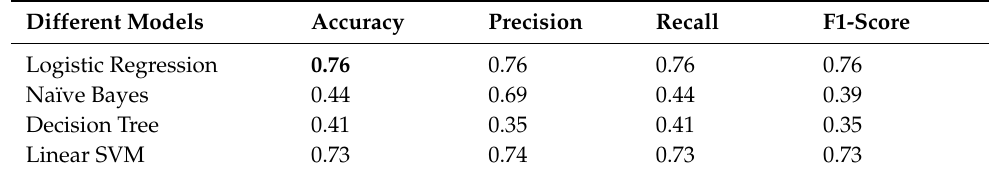
Table 6. Experimental results for “Trust Network Construction”.